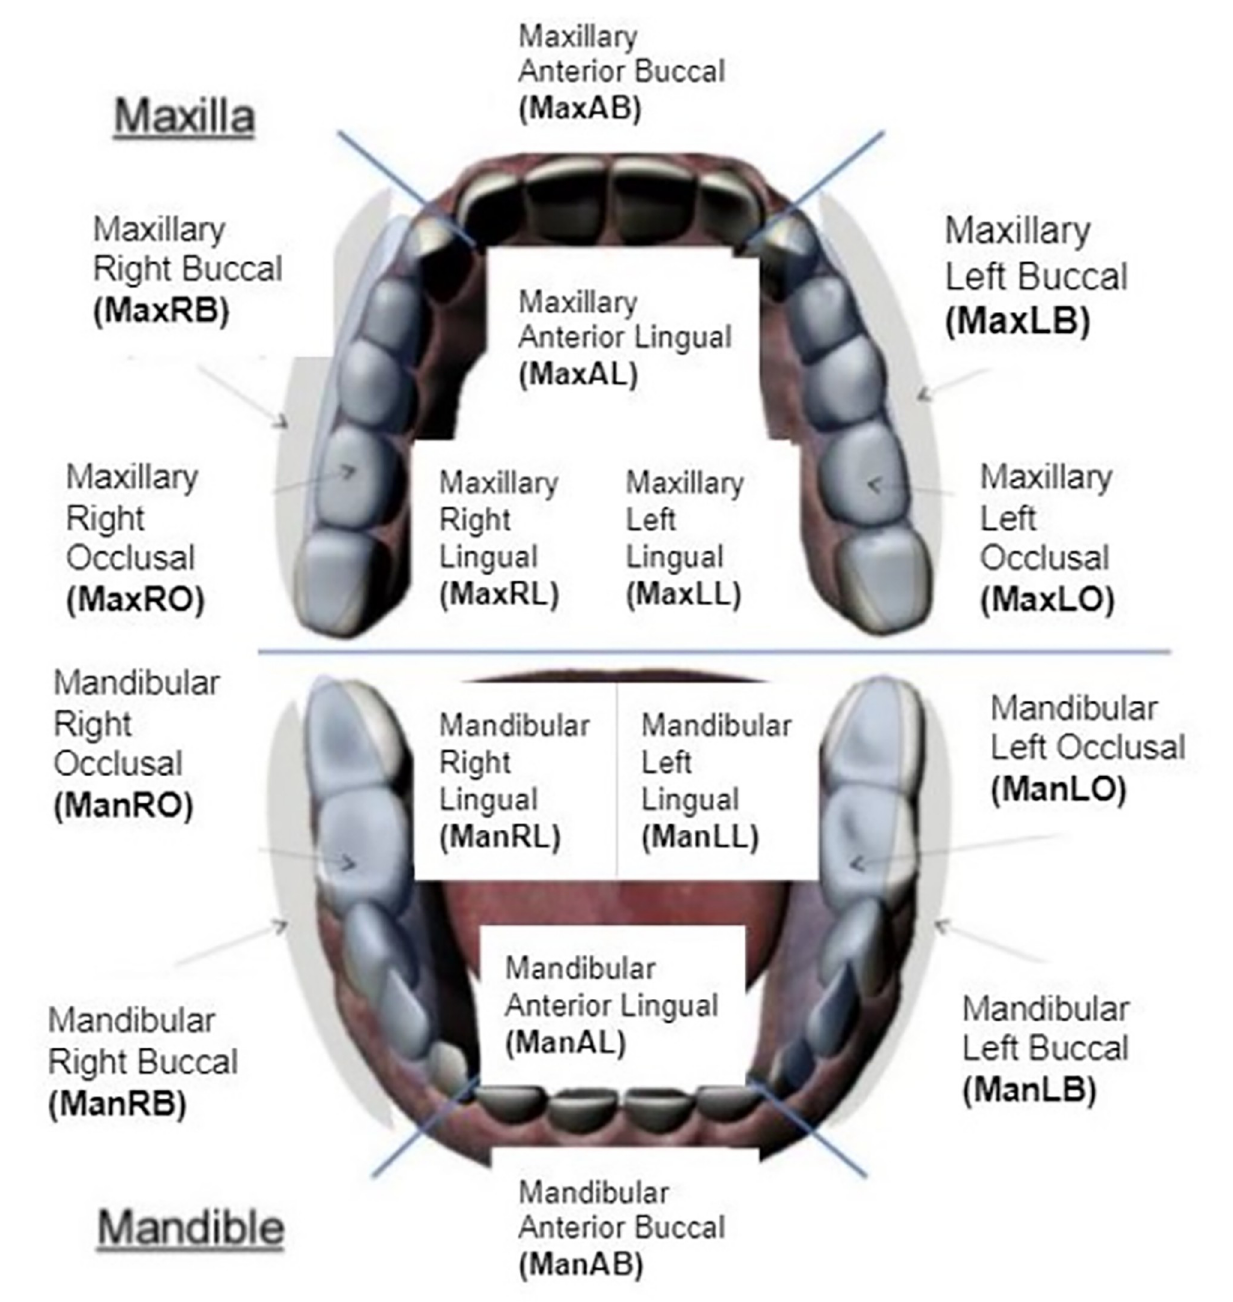
Fig 1. 16 dental surfaces considered in this study (image retrieved from